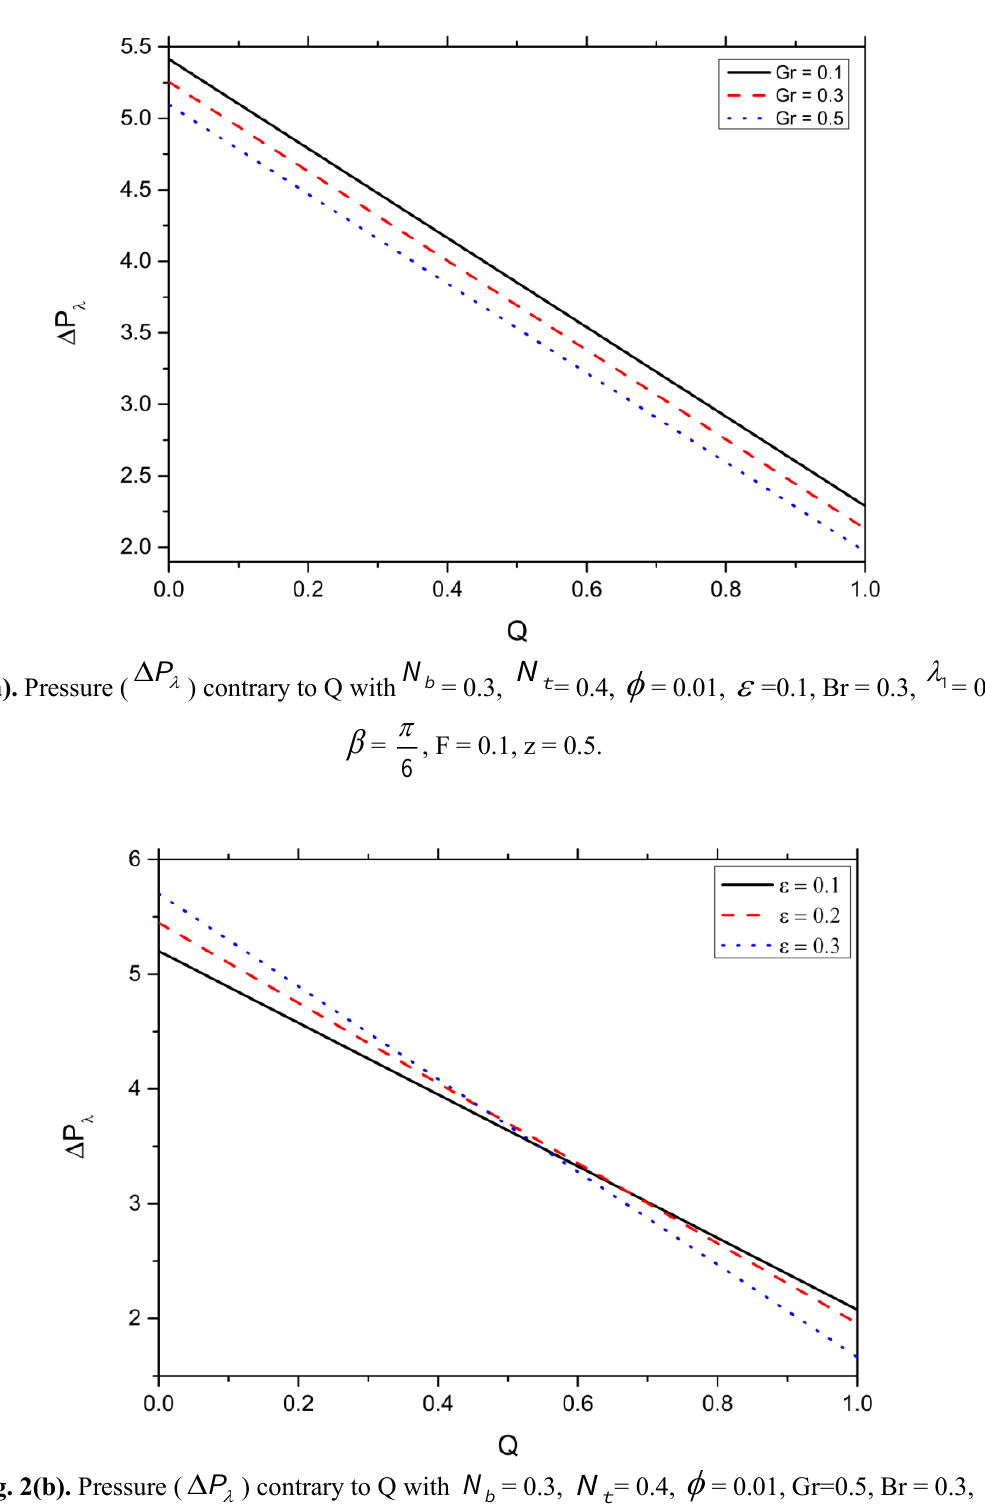
Fig. 2(b). Pressure ( P